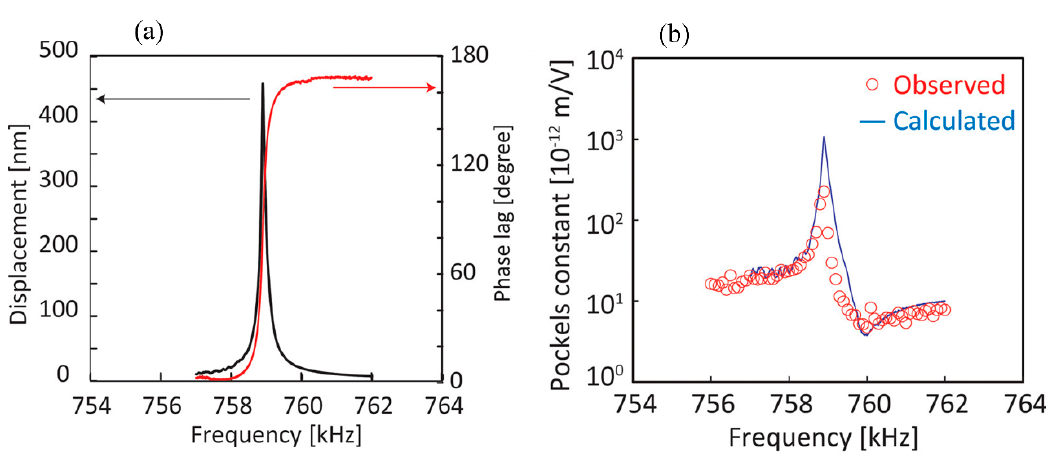
Figure 1. ( a ) Piezoelectric displacement and phase-lag between the E-field and piezoelectric displacement as a function of frequency; ( b ) calculated and observed electro-optical (EO)-coefficients as a function of frequency. Reprinted from [13], with the permission of AIP Publishing.